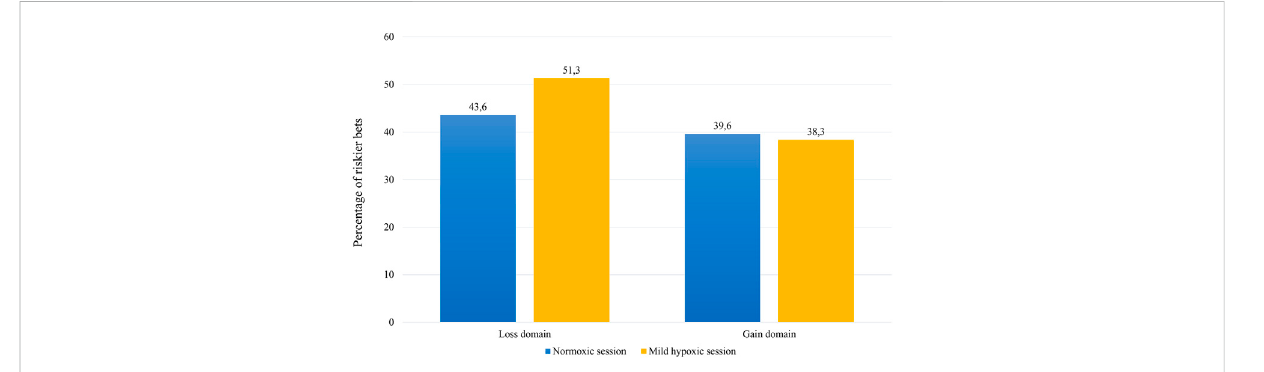
FIGURE 2 Probability of choosing the riskier bet as a function of probability ratio by session (normoxic and mild hypoxic) and domain (loss and gain).